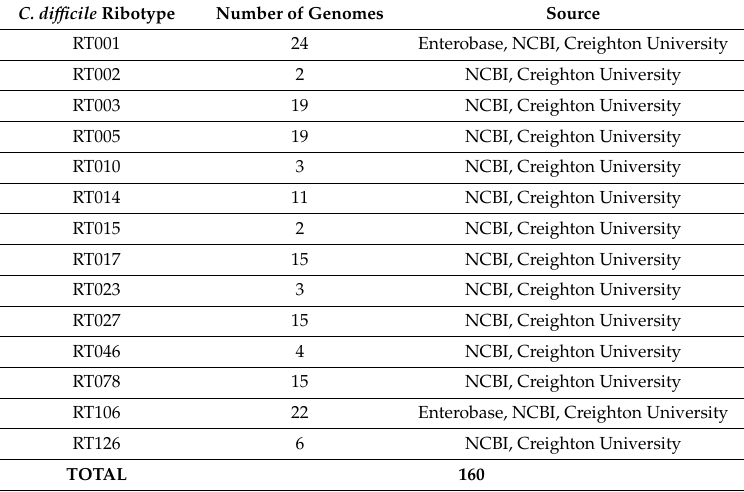
Table 2. C. di ffi cile ribotypes included in the training dataset along with the number of genomes and their source of